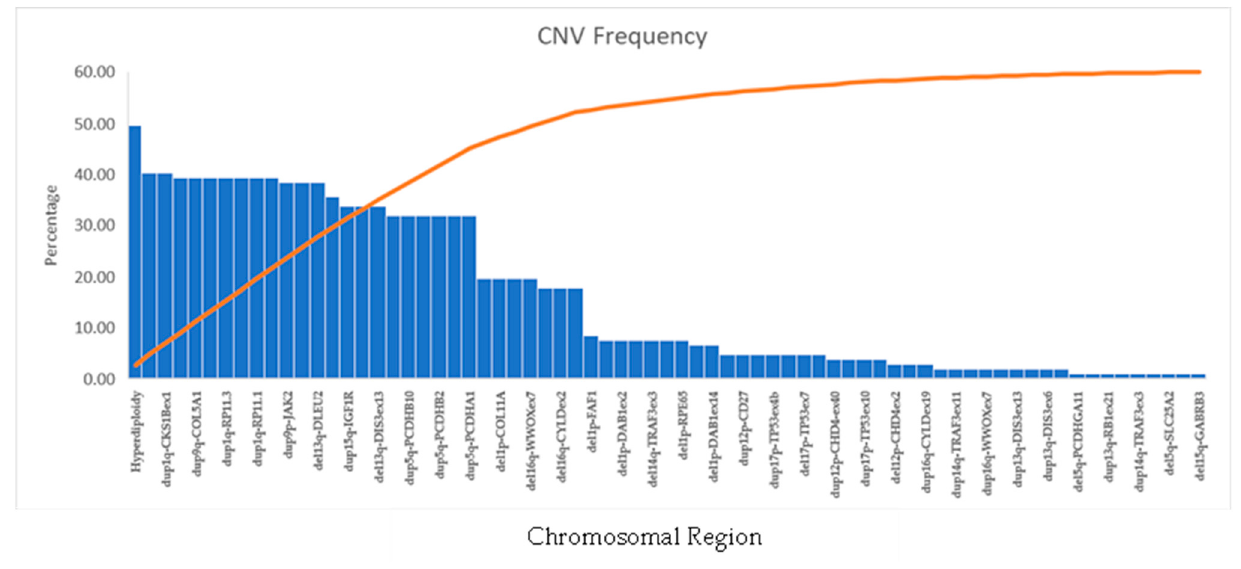
Figure A2. Frequency of the CNAs in the study group.